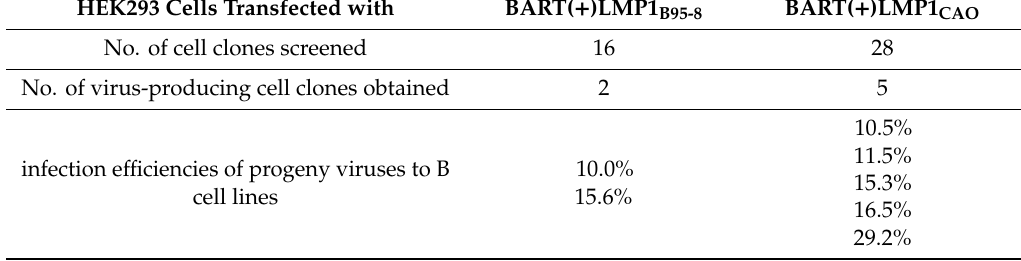
Table 1. Virus-producing cell clones obtained by transfection of EBV-BAC clones into HEK293 cells. HEK293 Cells Transfected with